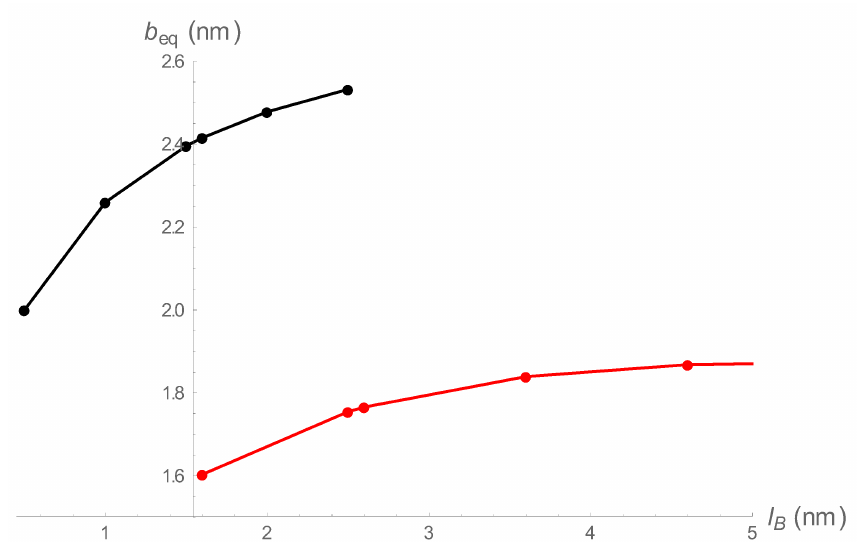
Figure 2. Equilibrium charge spacings as functions of Bjerrum length for low charge densities (black) and high charge densities (red), both at spring constant 0.1 (nm) − 2 and 1:1 salt 0.01 M.